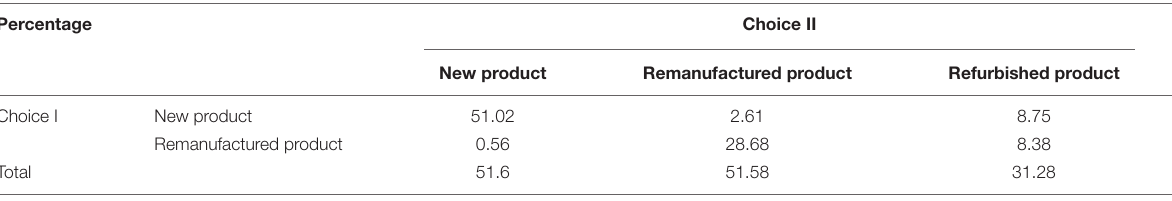
TABLE 4b | Consumers’ choice of cartridges I and II (%).